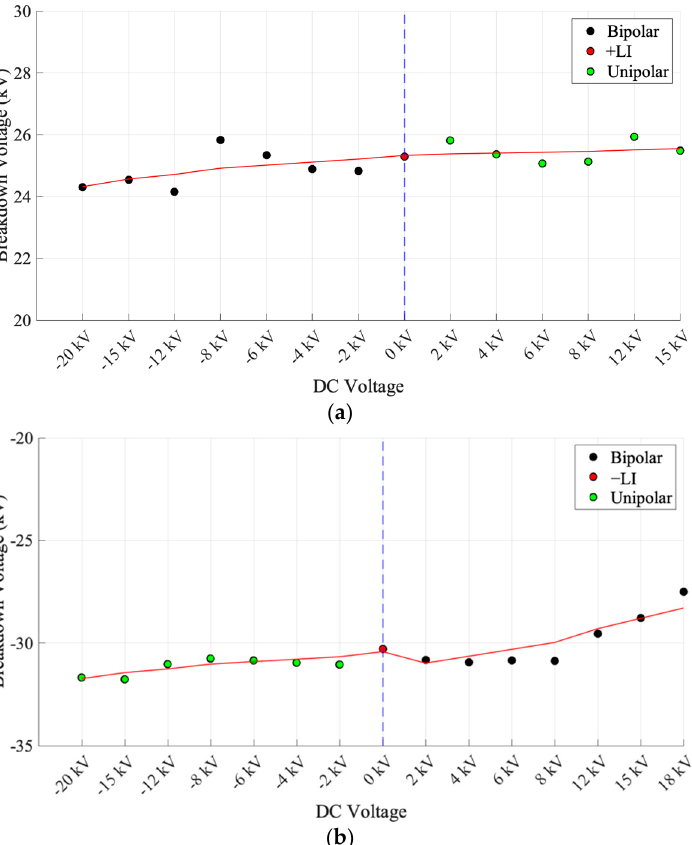
Table 3. Measured ambient conditions for breakdown experiments with (R = 1 mm)–plane electrode system.